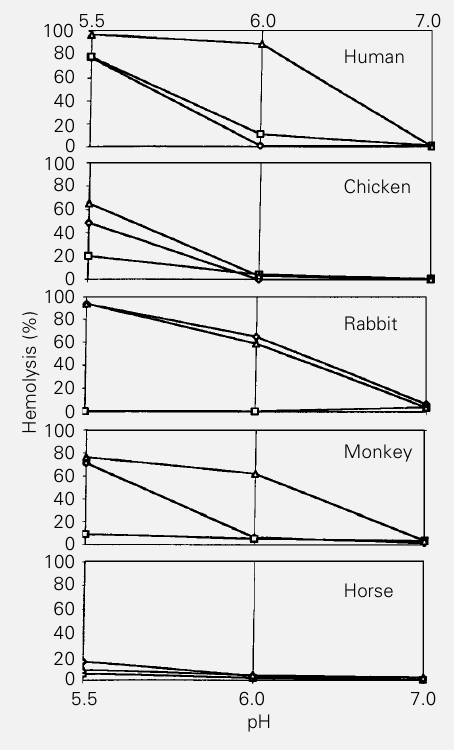
Figure 1 - Hemolytic activity of influenza viruses as a function of pH. The extent of hemolysis in- dicates the fusion activity of the viruses on human, chicken, rab- bit, monkey and horse erythro- cytes. Hemolysis was measured by absorbance at 545 nm, corre- sponding to the amount of he- moglobin released into the su- pernatant (6,9). All virus prepara- tions were previously standard- ized at 1,024 HAU/25 µl. Acetate buffers were used. Lozenges, In- fluenza A/Aichi/2/68; squares, in- fluenza B/Hong Kong/8/73; tri- angles, influenza C/Taylor/1233/